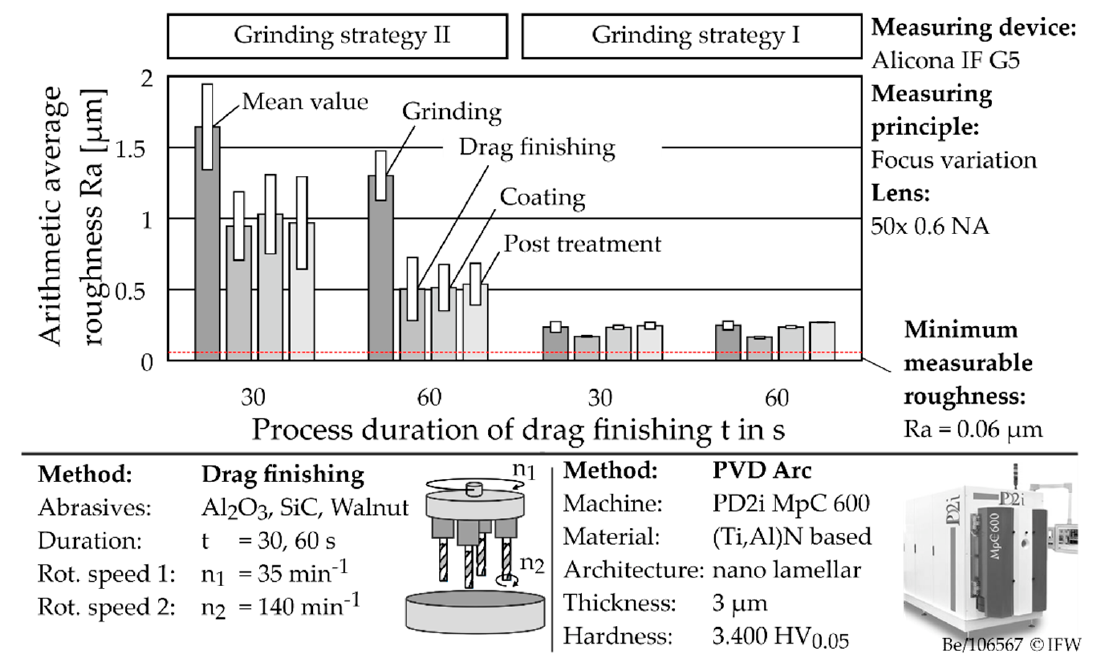
Figure 7. Influence of the investigated process steps in milling grinding on the arithmetic average roughness Ra.